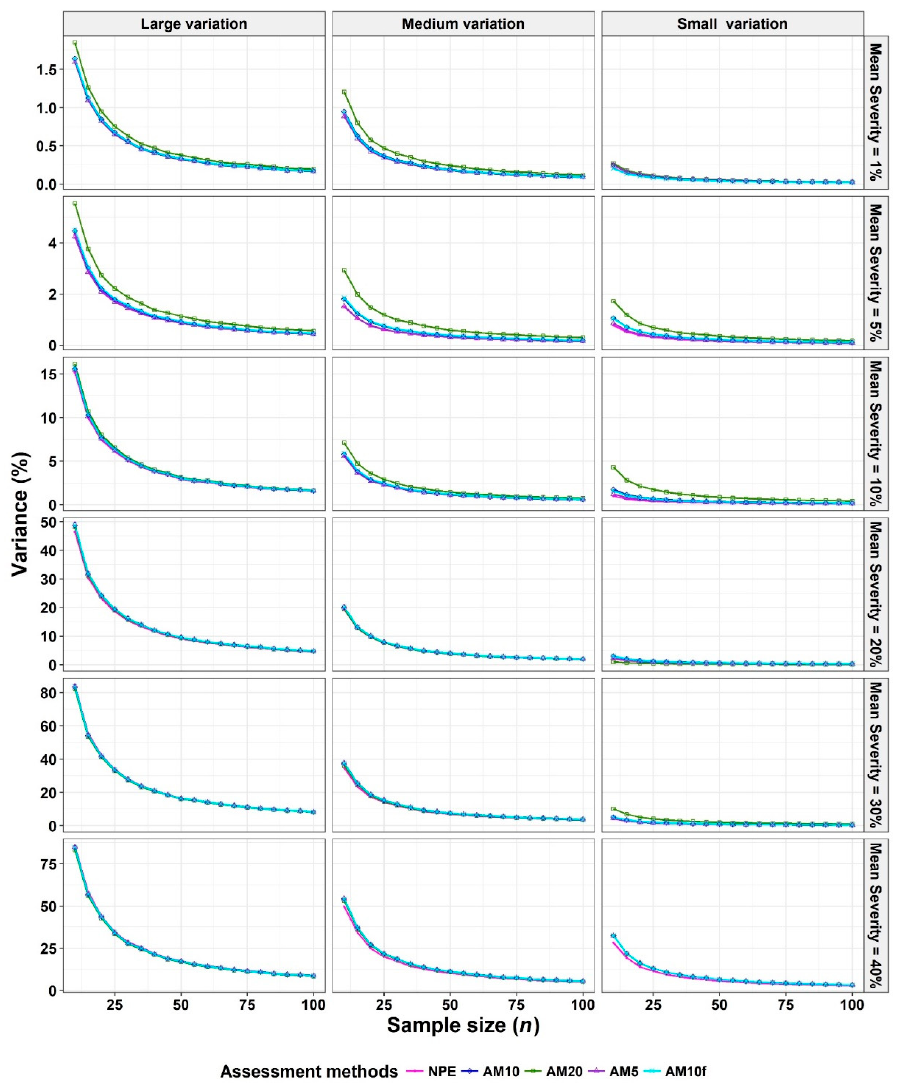
Figure 6. The relationships between the variance of mean disease severity estimates and sample size ( n ) (from n = 10 to 100 in n = 5 increments) for each of the different scales used, over a range of “actual” mean disease severities (1%, 5%, 10%, 20%, 30%, and 40%) and variance (represented by large, medium, and small variation). The simulation process was repeated 10,000 times. Assessment methods were: (i) NPE (nearest percentage estimate); (ii) AM10 (10% linear scale emphasizing severities ≤ 50% disease, and with additional intervals at severities <10%); (iii) AM20: Similar to the structure of AM10 (both scales have the same structure at ≤ 10%), this scale has wider ordinal scale intervals for disease severities 10 through 50% based on a 20% linear scale; (iv) AM5: Similar to the structure of AM10 (both scales have the same structure at ≤ 10%), this scale has narrower ordinal scale intervals for disease severities 10 through 50% based on a 5% linear scale; (v) AM10f: Similar to the structure of AM10, this scale has 10% linear intervals at >10%, but has finer intervals at ≤ 10% disease.